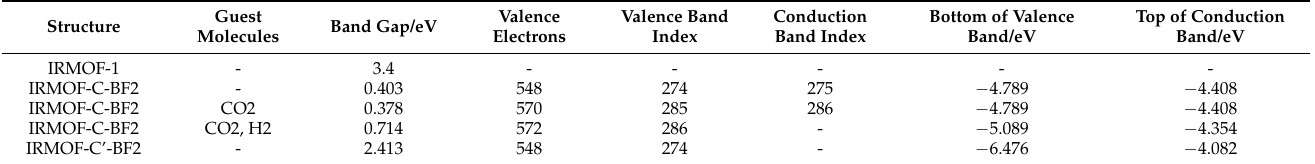
Table 8. Band properties for IRMOF-C-BF 2 unit cell with and without the guest molecules H 2 and CO 2 , and IRMOF-C’-BF 2 without guest molecules. The values for IRMOF-1 are cited as reference [33,34].